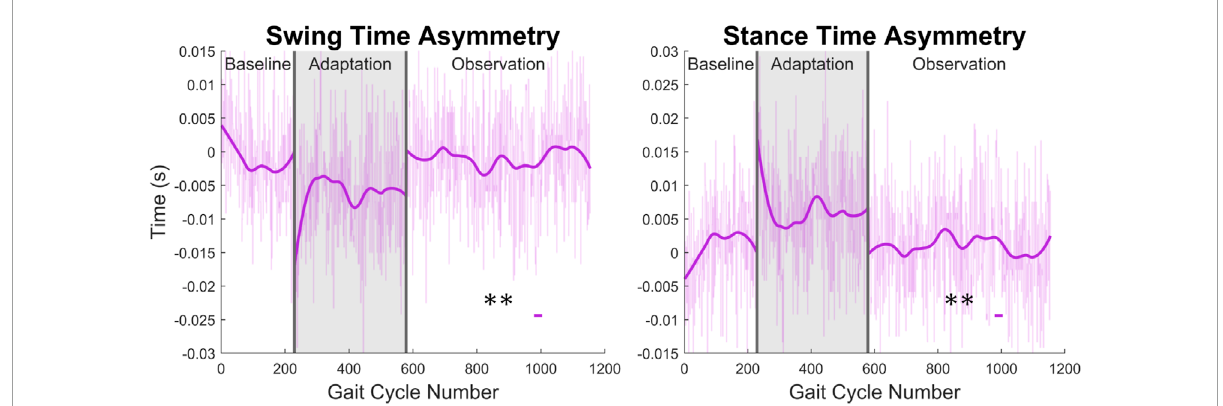
FIGURE 14 Swing and stance time asymmetry in terms of time. For the swing phase, asymmetry was found by subtracting the time spent in right swing from the time spent in left swing. For the stance phase, the same process was used. Significance is shown in the observation phase as compared to the baseline phase by the significance line. All significance testing was performed on “unsmoothed” data (seen in the lighter line). The darker line is the data smoothed by 2nd-degree polynomial local regression and was added only to allow the reader to more clearly see trends in the data.